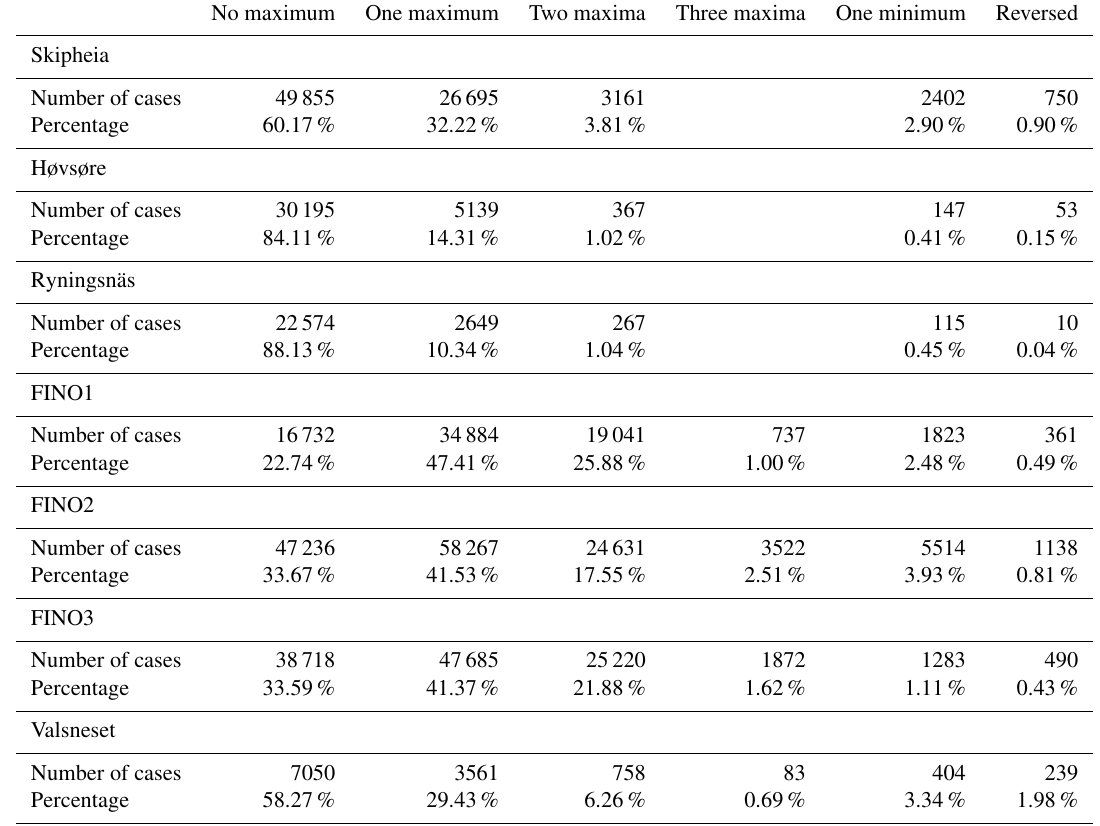
Table 3. Occurrence of different profile categories at all sites. Blank spaces indicate that the site had too few measurement heights for the profile category to be